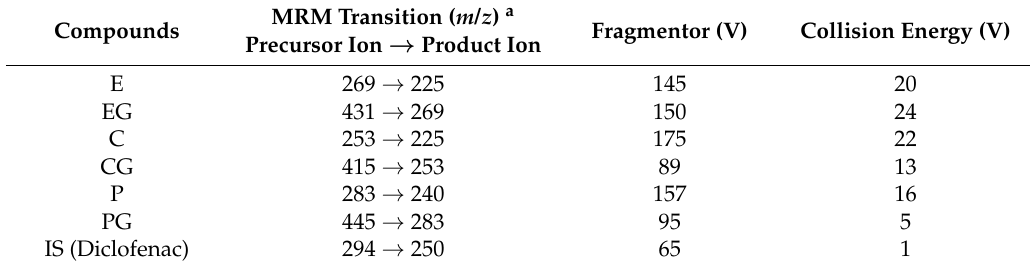
Table 1. Summary of the MS/MS